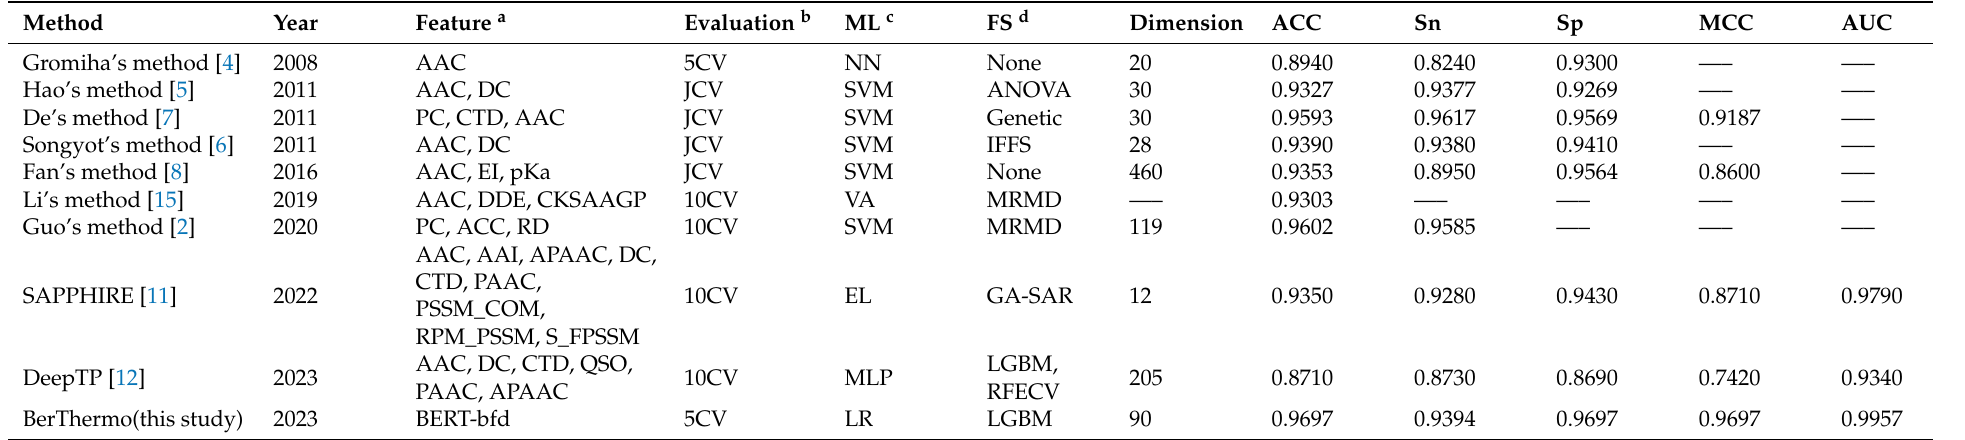
Table 3. Comparison of our model and previous models on